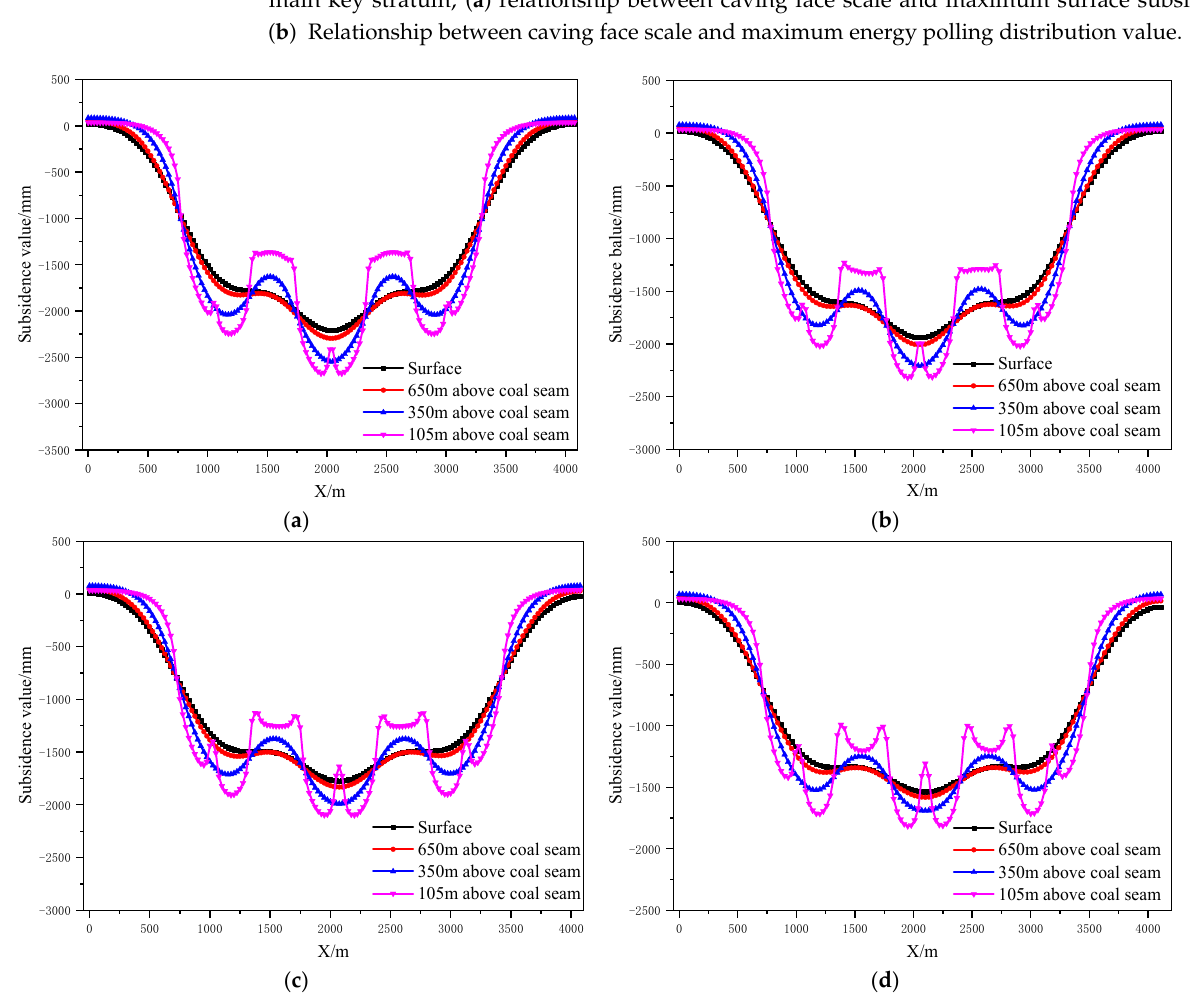
Figure 16. Strata and surface subsidence rule of partial filling mining based on main key stratum in different section pillar scale; ( a ) With of section pillar = 25 m. ( b ) With of section pillar = 30 m. ( c ) With of section pillar = 50 m. ( d ) With of section pillar = 60 m.